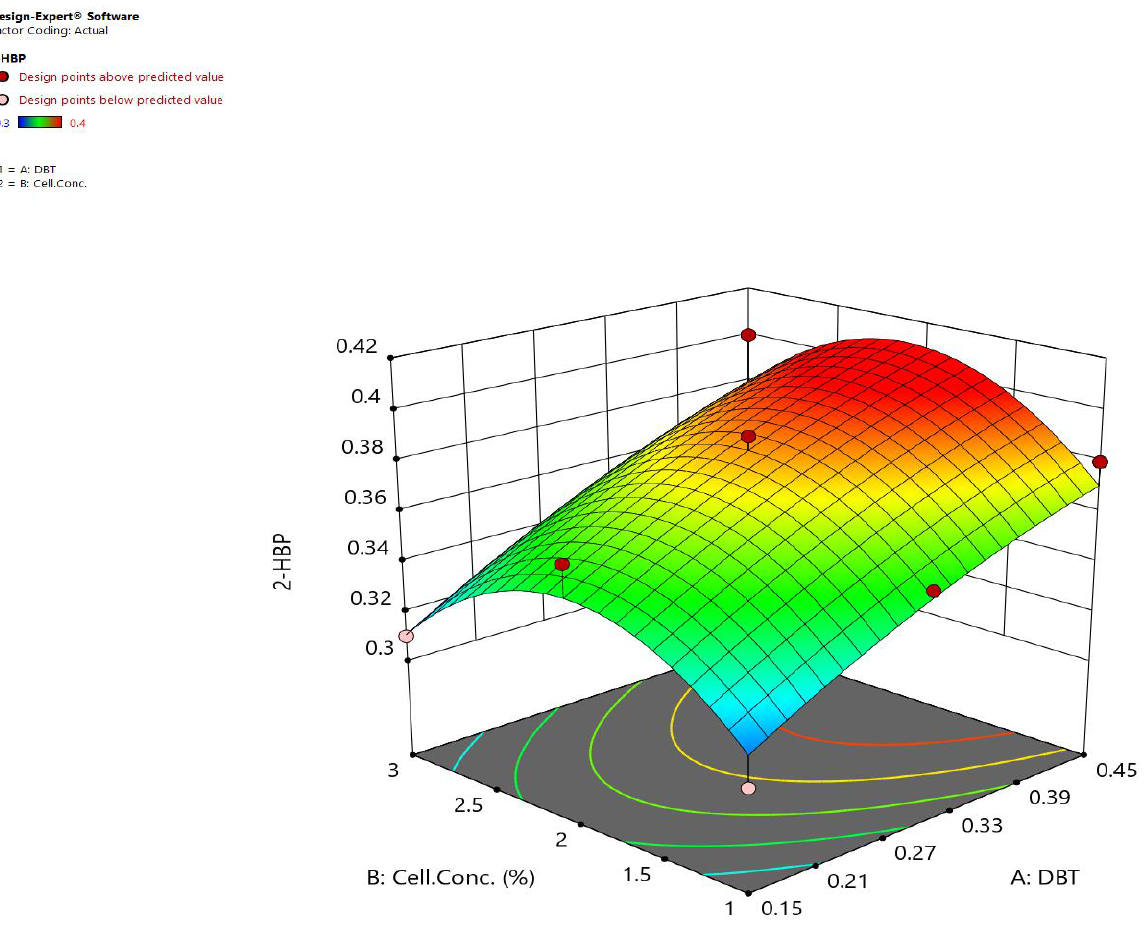
Figure 3. Three-dimensional plot of interactions of A: concentration of sulfur (dibenzothiophene) and B: cell concentration.